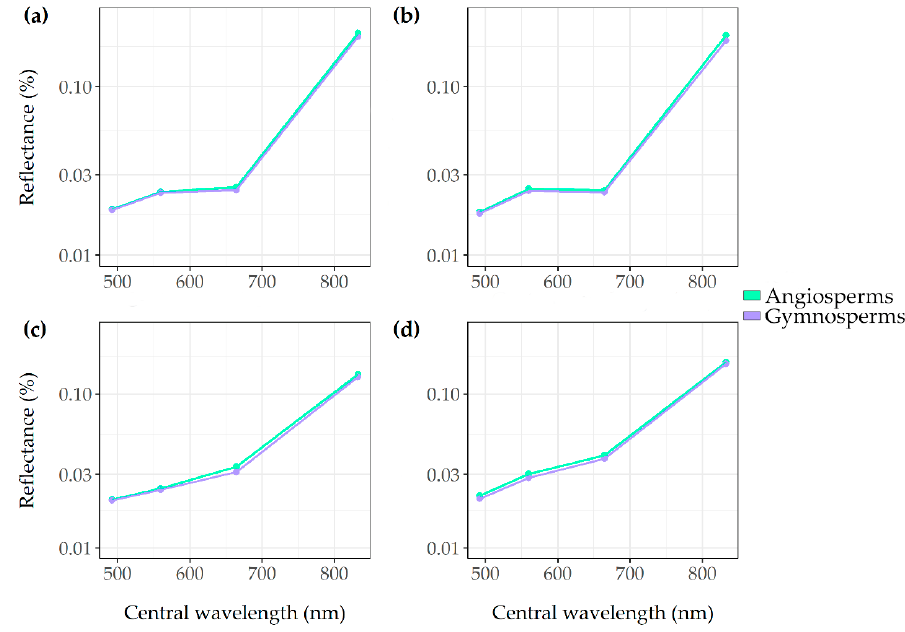
Figure A5. Mean spectral reflectance of the tree phyla for the blue (B02), green (B03), the red (B04), and the near infrared (B08) Sentinel-2 bands. For each season, the reflectance is calculated: summer ( a ), autumn ( b ), winter ( c ), and spring ( d ).